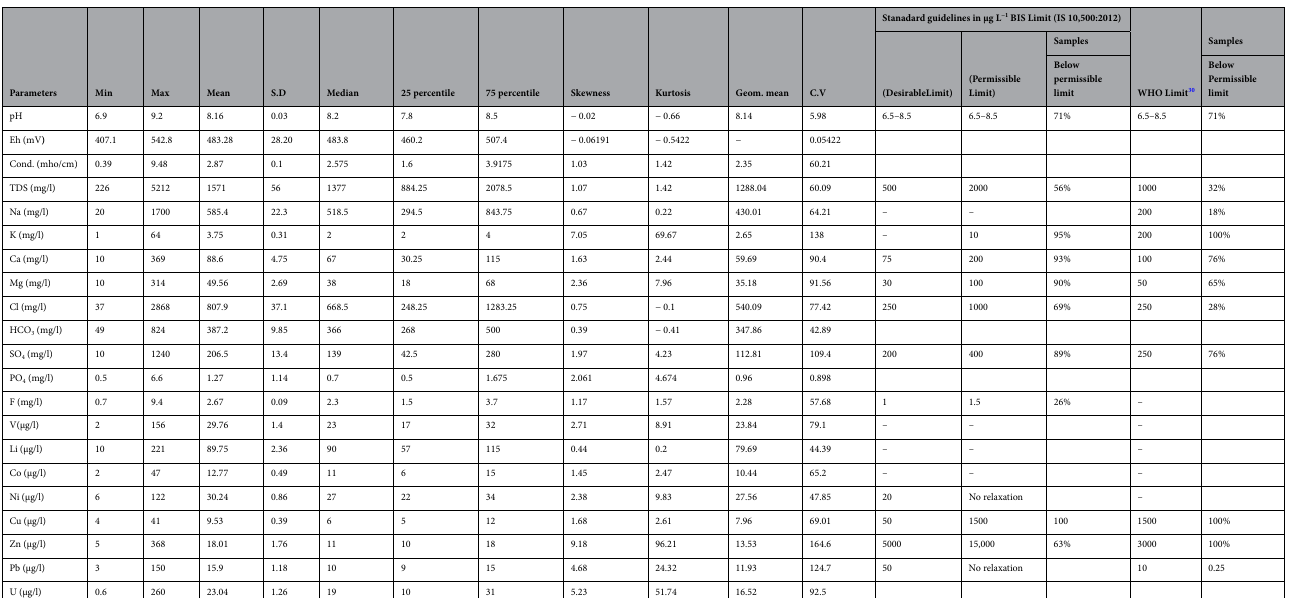
Table 1. Descriptive statistical analysis of Physico-chemical and metalloids in groundwater from western part of Rajasthan and northern part of Gujarat (n =